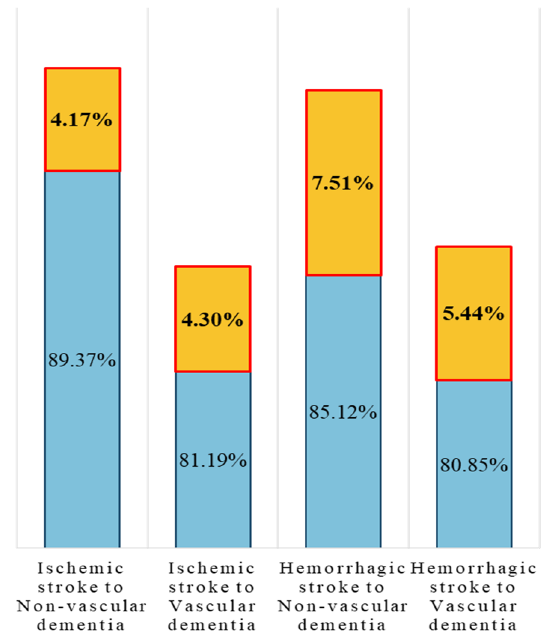
Figure 3. Improvement by the proposed models as compared to only considering medication and rehabilitation.